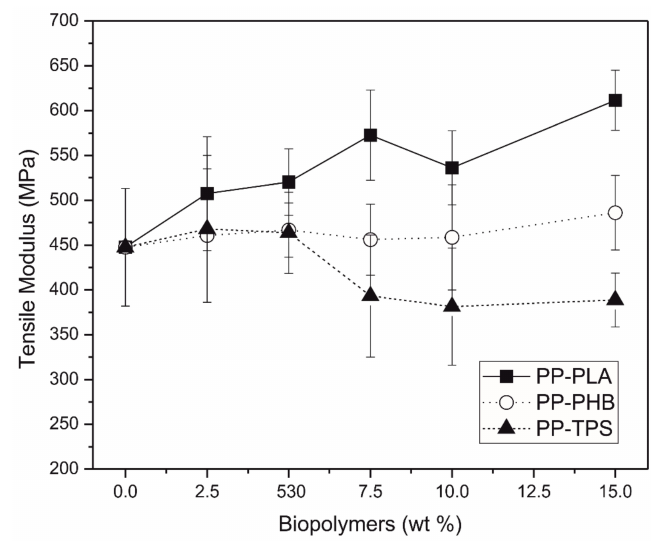
Figure 8. Variation of modulus of elasticity vs. wt.% biodegradable polymer in